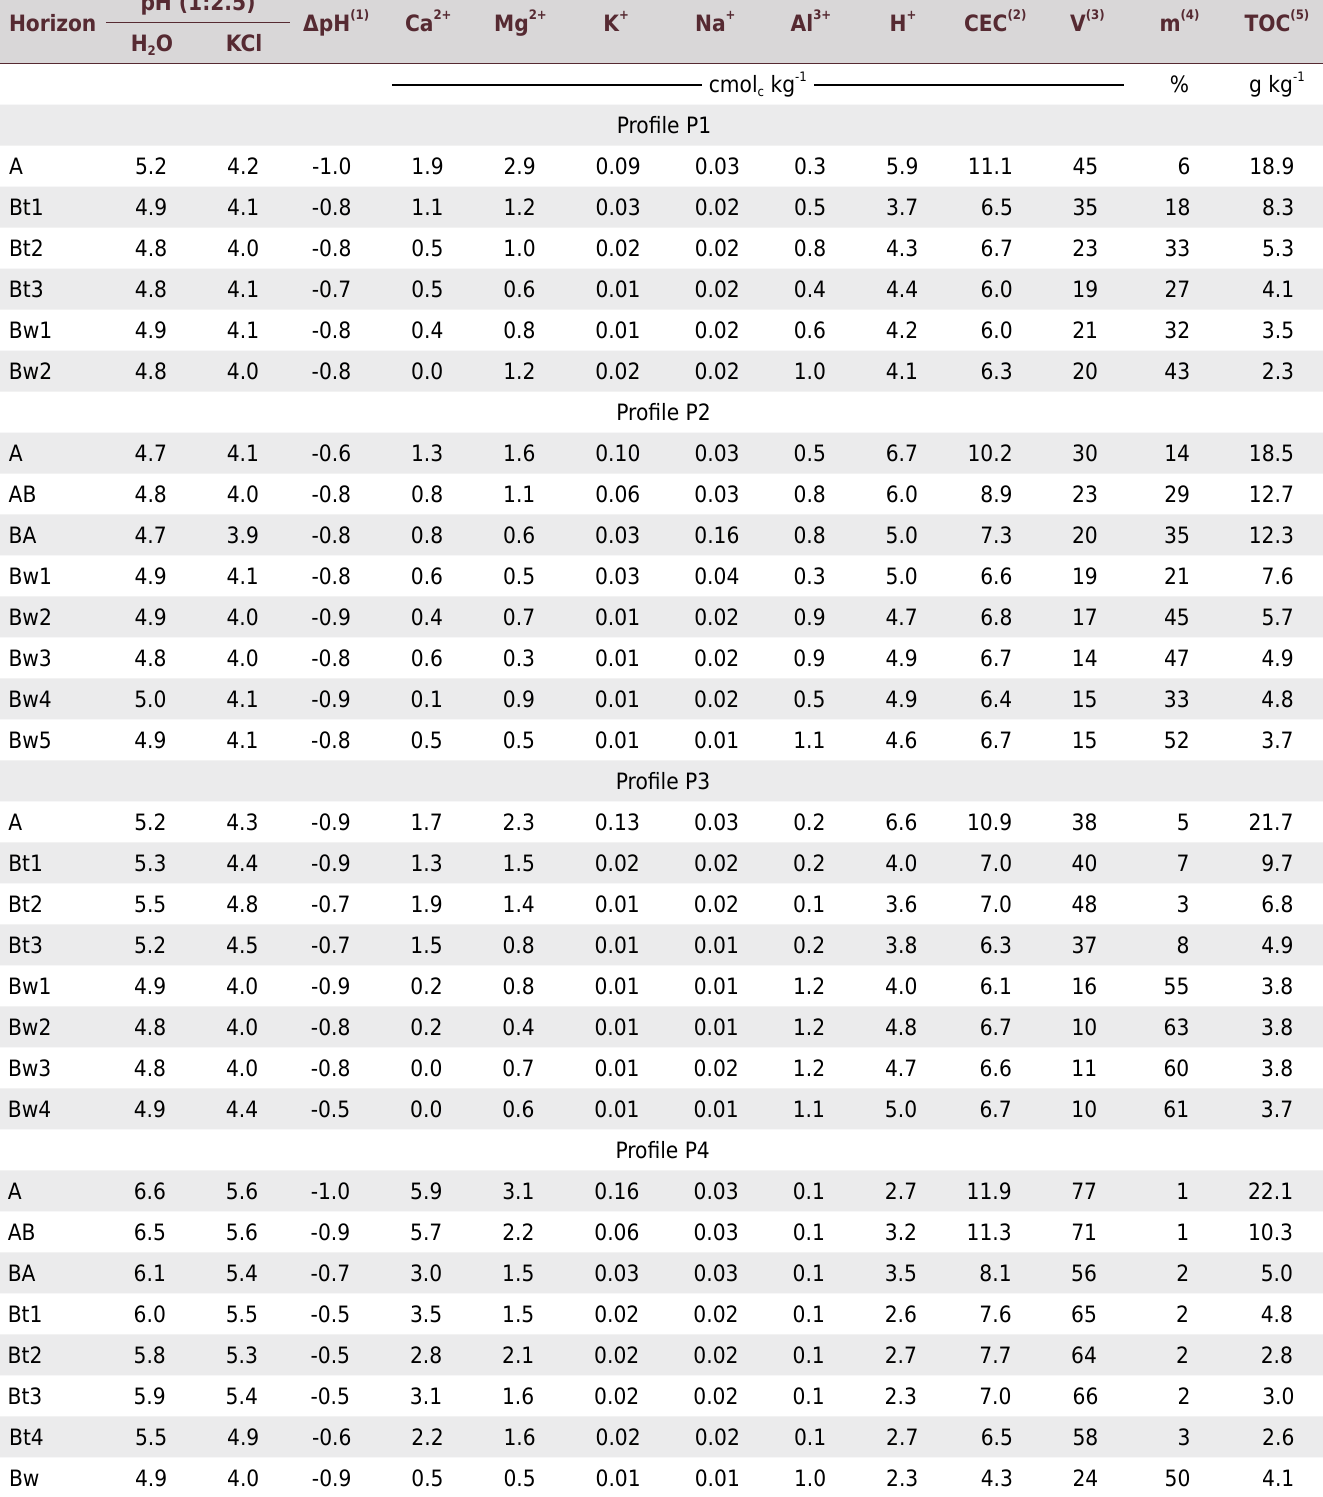
Table 3. Chemical properties of the sampled soils in the Rio de Janeiro State, Southeastern Brazil pH Horizon